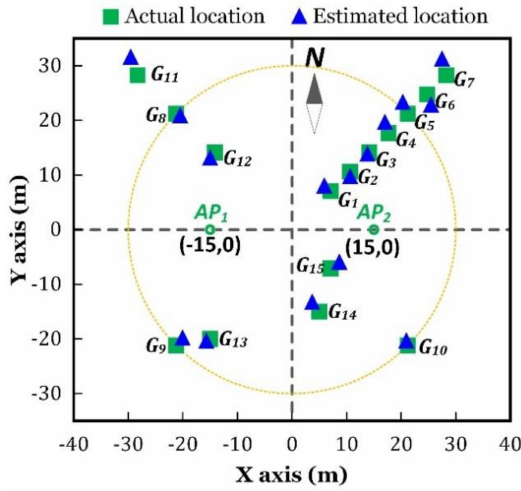
Figure 6. Indoor localization